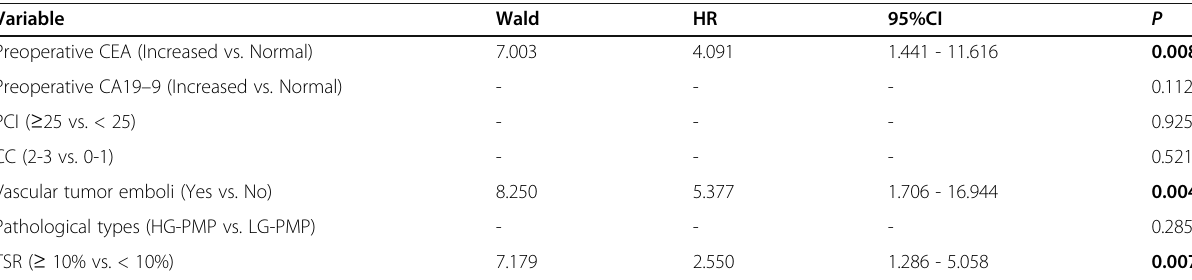
Table 3 Multivariate survival analysis of 50 PMP